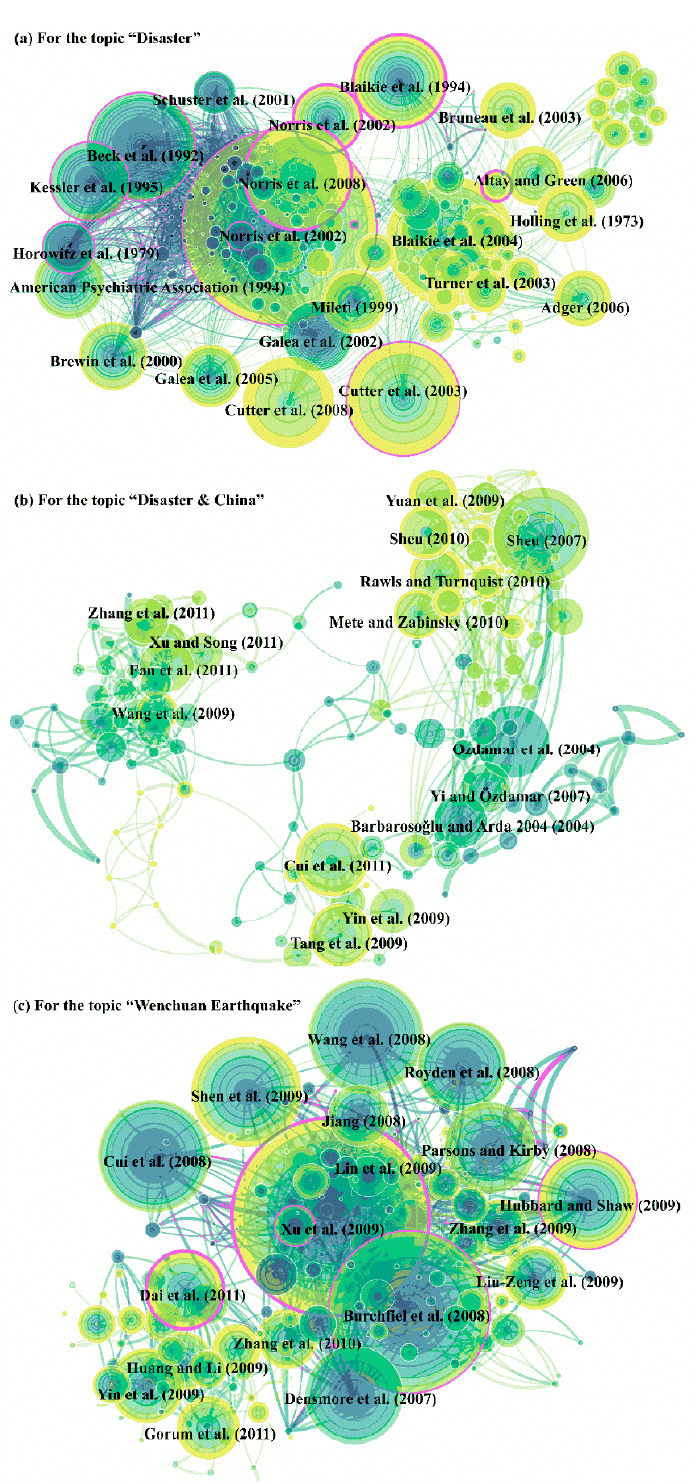
Figure 6 . Cited reference network for the “Disaster” topic. Figure 6. Cited reference network for the “Disaster”